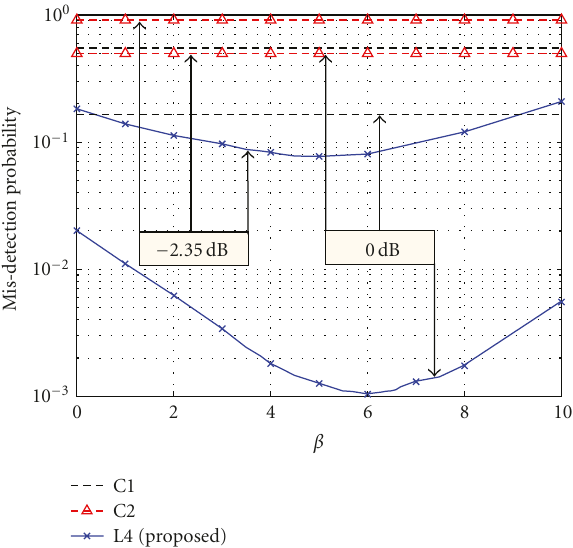
Figure 5: Misdetection probability of the L4 detector for di ff erent correction weights at CFAR of 10 − 3 ( f m T s =